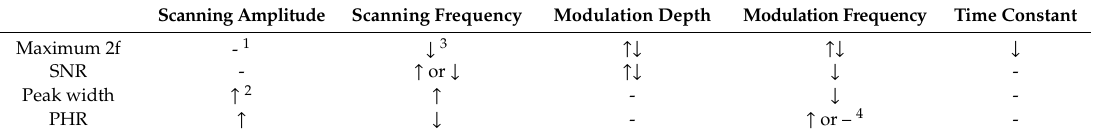
Table 4. E ff ects of di ff erent control parameters on 2 f signals. PHR: peak height